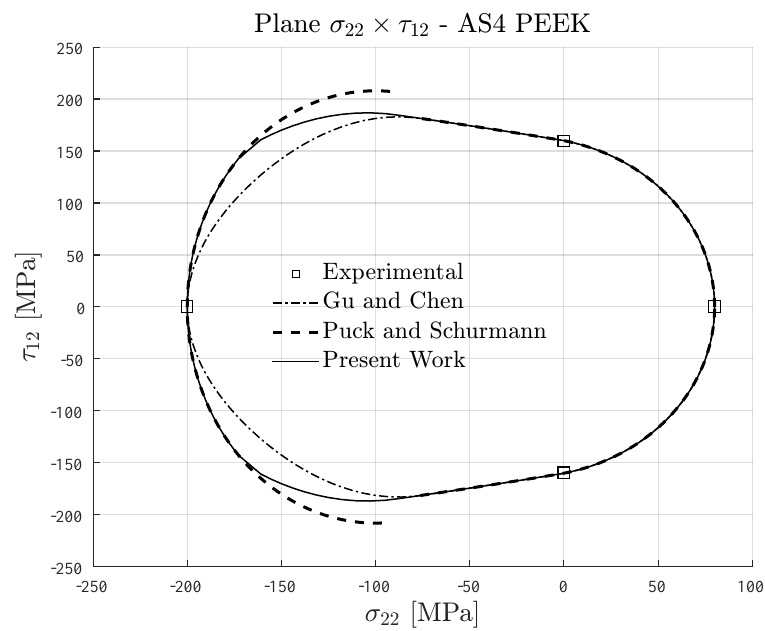
Figure 14. Failure envelopes on the stress space σ 22 × τ 12 for AS4-PEEK. Inclination parameter = 0.3 for Puck and Schürmann and Expanded Puck and Schürmann. p c ⊥⊥